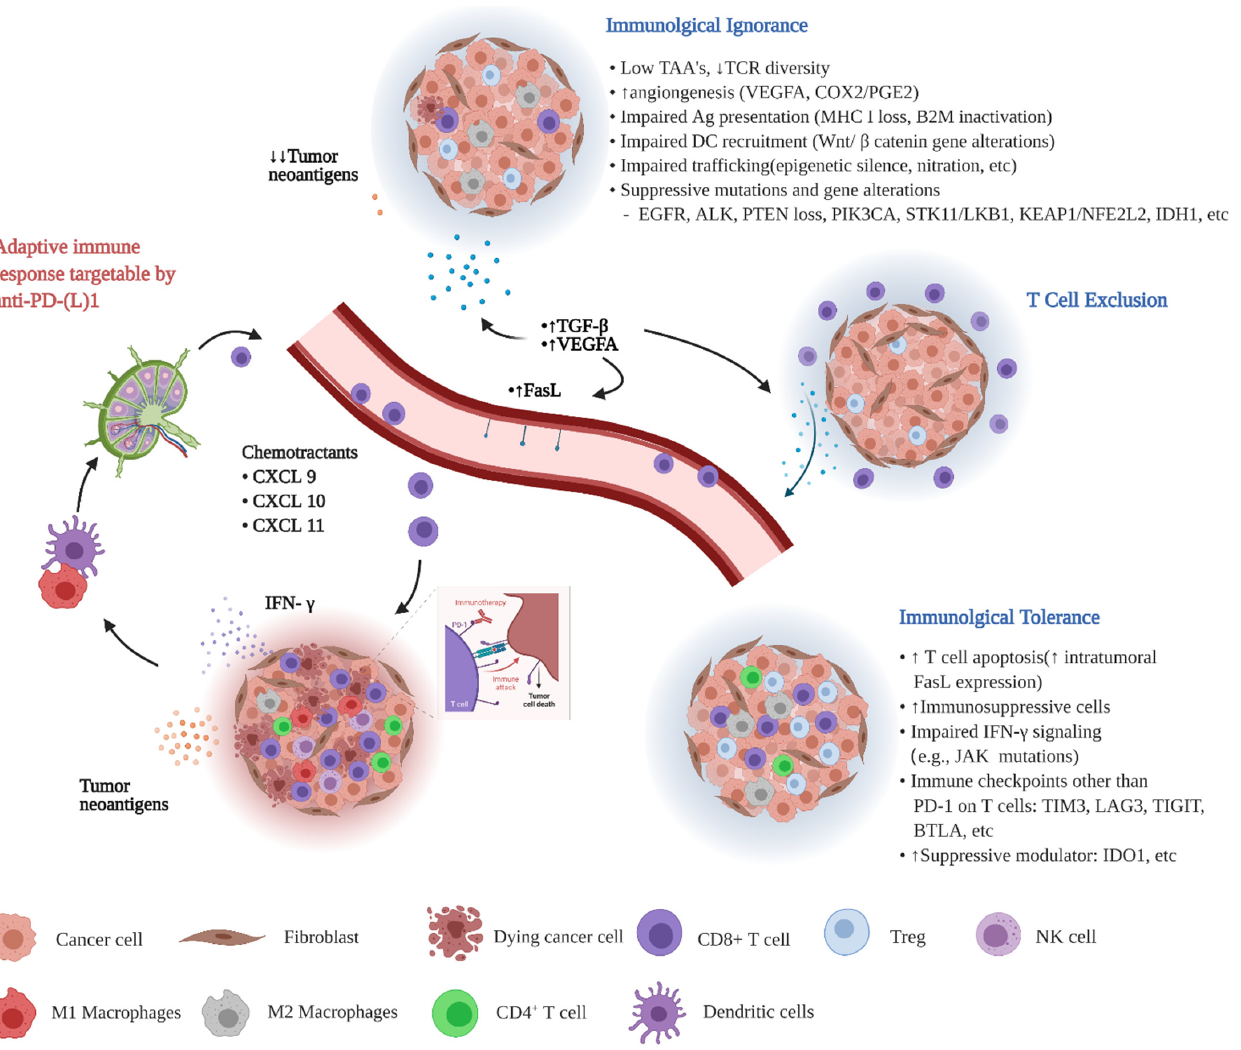
Figure 1. Characteristics of different types of TIME related to NSCLC’s response to ICI. In NSCLC, immune tolerance commonly results from loss-of-function JAK muta- tions; T cell exhaustion/apoptosis; increased expression of suppressive modulators and cytokines, such as IDO1 and TGF- β ; and the suppression of normal CD8 + T cells’ interac- tion with tumor cells by Tregs and MDSCs [55–61,63,64,71–81]. These impairments reflect a state of T cell suppression/exhaustion and poor tumor cell recognition. They may be present in TIME subtypes with various magnitudes of CD8 + T cell infiltration or enriched with immunosuppressive cytokines, such as the IFN- γ -dominant or the TGF- β -dominant subtypes. When identified with a specific TIME subtype, treatment strategies combining ICI with other therapeutic agents, treatment modalities, or using other treatment ap- proaches for immune activation may be developed to maximize antitumor response. For instance, activating the cGAS-STING pathway with radiotherapy, chemotherapy, STING agonists, or double-stranded (ds) DNA sensing-targeted nano-therapy along with adop- tive T cell therapy may be considered in the presence of loss of function JAK mutations [64–68,141–143]. Among them, adoptive T cell therapy may also be combined with ICIs to provide a therapeutic solution to FasL-induced T cell apoptosis [144]. Cancer progression has been associated with increased terminal T cell exhaustion through additional immune checkpoints, such as LAG-3, TIM-3, TIGIT, and BTLA [73–77]. Inhibitors of these immune